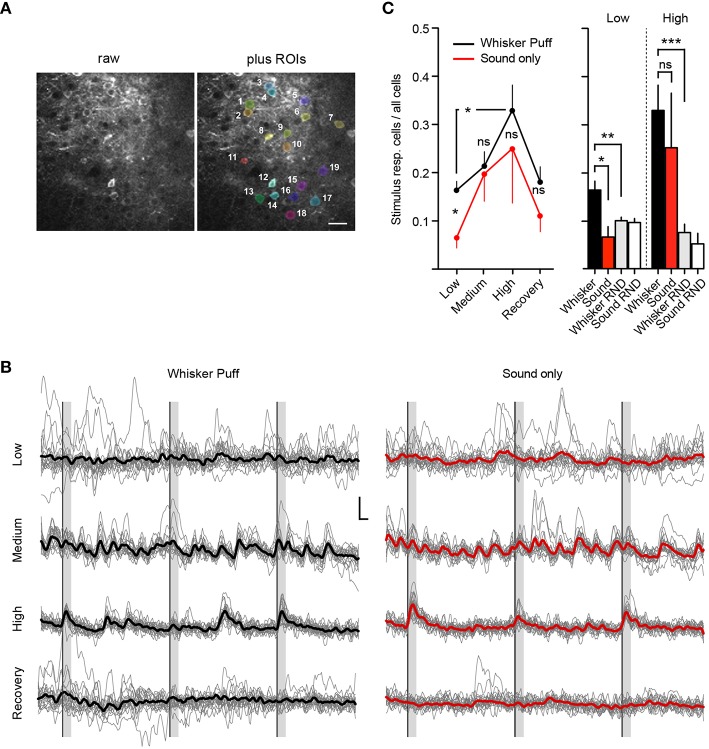
Deep isoflurane anesthesia affects cortical information processing. (A) Example field of view showing the raw image (Left) and an overlay of analyzed ROIs (Right), scale bar 25 μm. (B) Example traces of imaged cells shown in (A) for whisker puff and sound only trials for each isoflurane concentration, inset: 10% ΔR/R (y-axis), 2 s (x-axis), thick lines indicate group average. (C) Fraction of neurons responding to whisker stimulation by an air-puff and sound-only stimulation under low (0.5%), medium (1.0%), and high (1.5–2.0%) isoflurane doses, and after recovery (0.5%) (Mean ± SEM, *p < 0.05, only significant differences between stimulation groups and isoflurane treatments are marked in the figure). The differences in sensory responsiveness at low isoflurane vanished when the stimulus detection windows were randomized within datasets (RND) (see Section Materials and Methods) (mean ± SEM, **p < 0.01, ***p < 0.001).